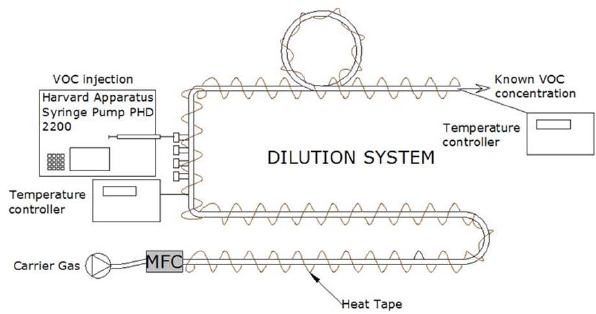
Fig. 1. Schematic of the dynamic dilution system built for generat- ing gas terpenoid standards.